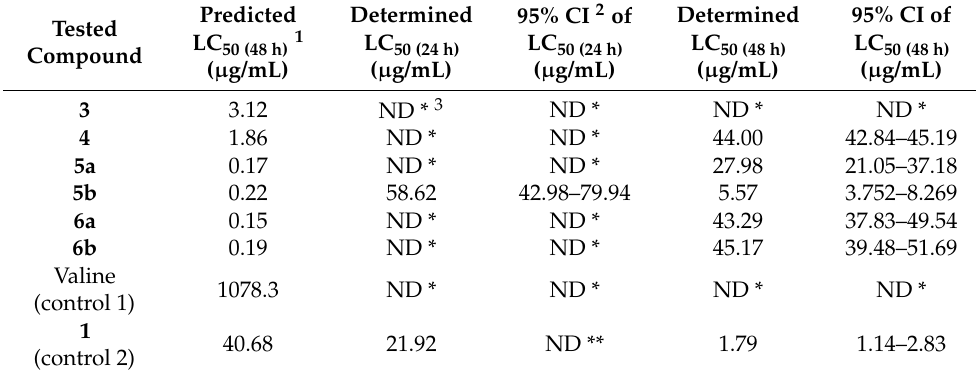
Table 5. Daphnia magna bioassay: 24 h and 48 h values, 95% confidence intervals for newly synthesized compounds and their starting